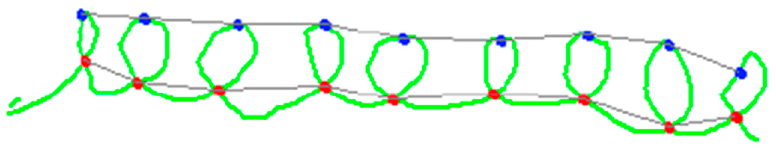
Figure 3. Extracted from Elian Research software (Version 4.2, http://www.seldage.com, accessed on 24 September 2022). Each point forming the line of loops, the highest point of the loop, and the intersection point are recorded for the calculation of the following features: total drawing length, average length per stroke, drawing width, drawing height, degree of inclination of the line, height of the loops, spacing between loops, number of loops, number of strokes, total drawing time, effective drawing time, number of on-paper pauses, number of in-air pauses, number of velocity peaks, average and maximum velocity.